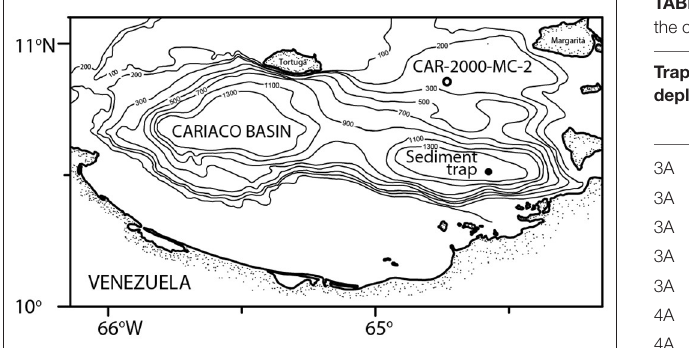
FIGURE 1 | Location of the sediment trap (filled circle) and the CAR2000-MC-2 core (open circle) where specimens from this study were collected.